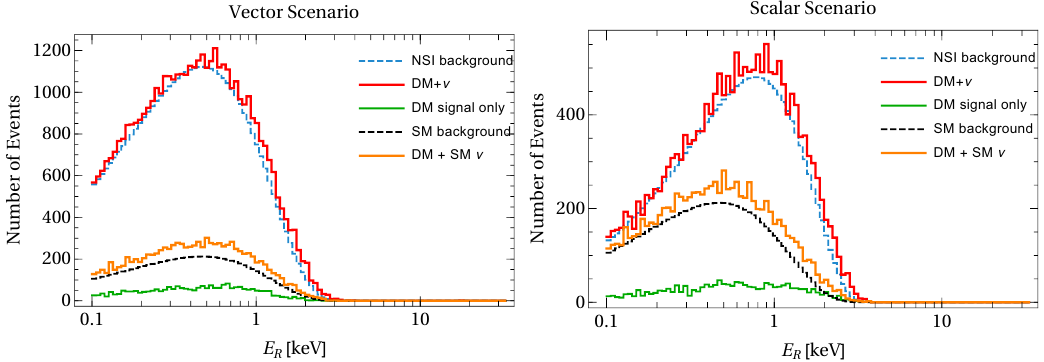
Figure 7 . Recoil spectrum in the vector (left) and scalar (right) case for the parameter point corresponding to the red star in (cid:12)gure 4 and (cid:12)gure 5, respectively. The di(cid:11)erent contributions are shown separately: DM only (green), standard CNSN (black), non-standard CNSN (blue) as well as the combined spectrum (red).